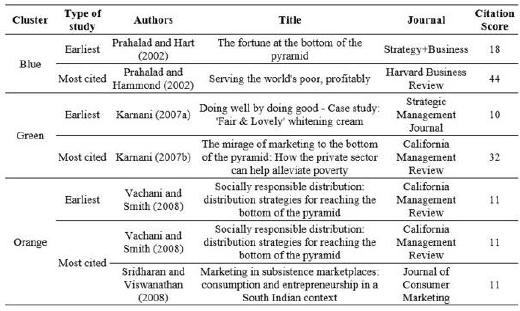
Table 4: Earliest and Most Cited Publication in Each Cluster of the Citations